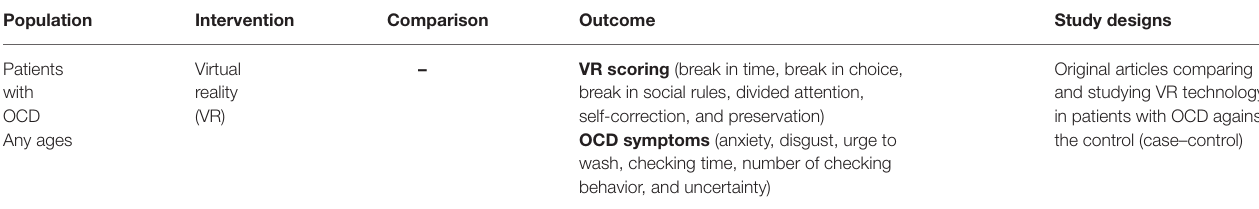
TABLE 1 | The description of populations, interventions, comparators, outcomes, and study designs (PICOS) used in this review.